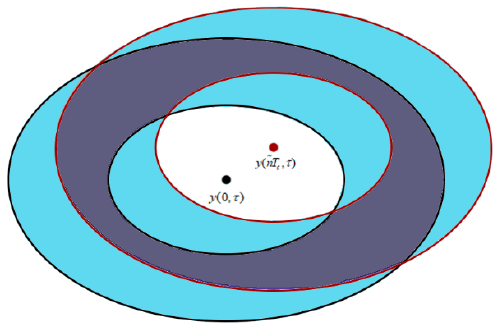
+  y nT τ y nT nT τ c c c